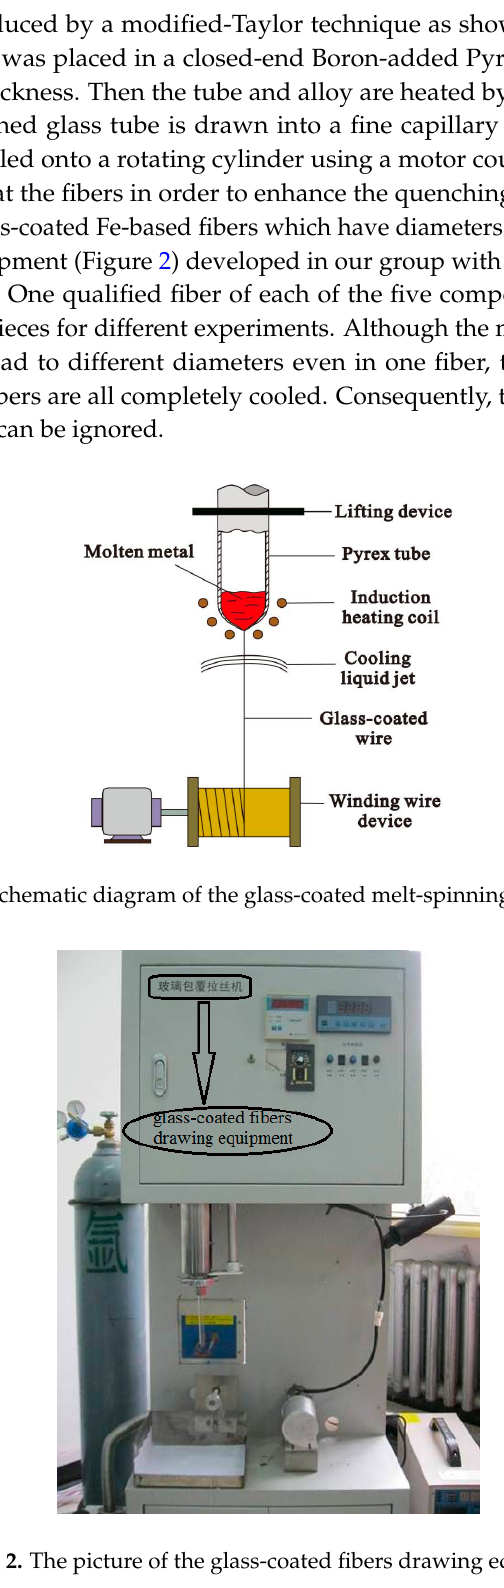
Figure 2. The picture of the glass ‐ coated fibers drawing equipment.